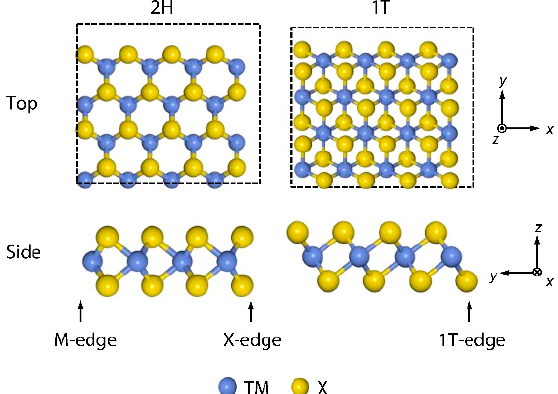
Figure 15. Structure of 2H and 1T MX 2 dichalcogenides (top view). Reprinted with permission from [176]. Copyright 2015 Elsevier.